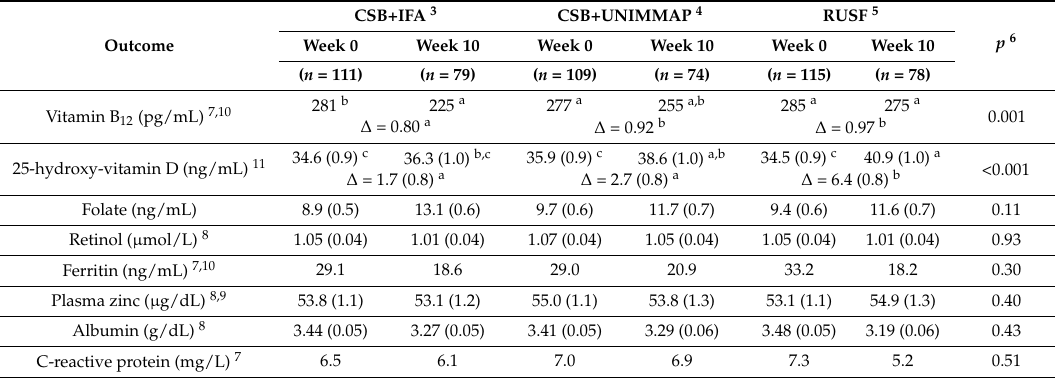
Table 5. Adjusted 1 mean (SE) or geomean serum/plasma 2 concentrations by treatment group at week 0 and week